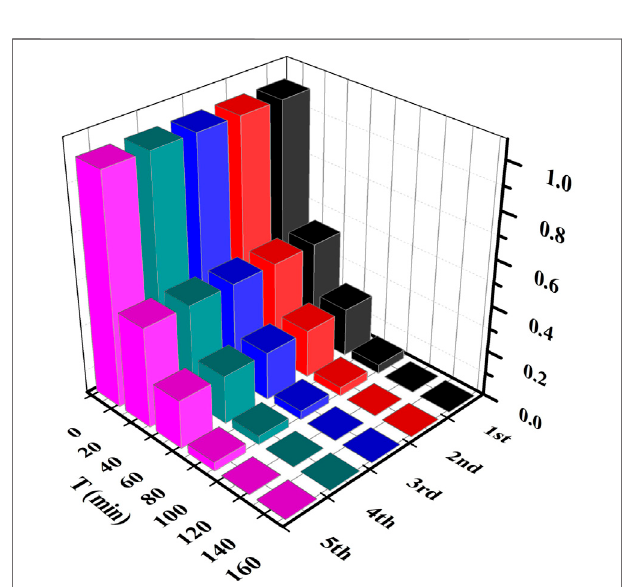
FIGURE 8 | Cycling experiment of 1